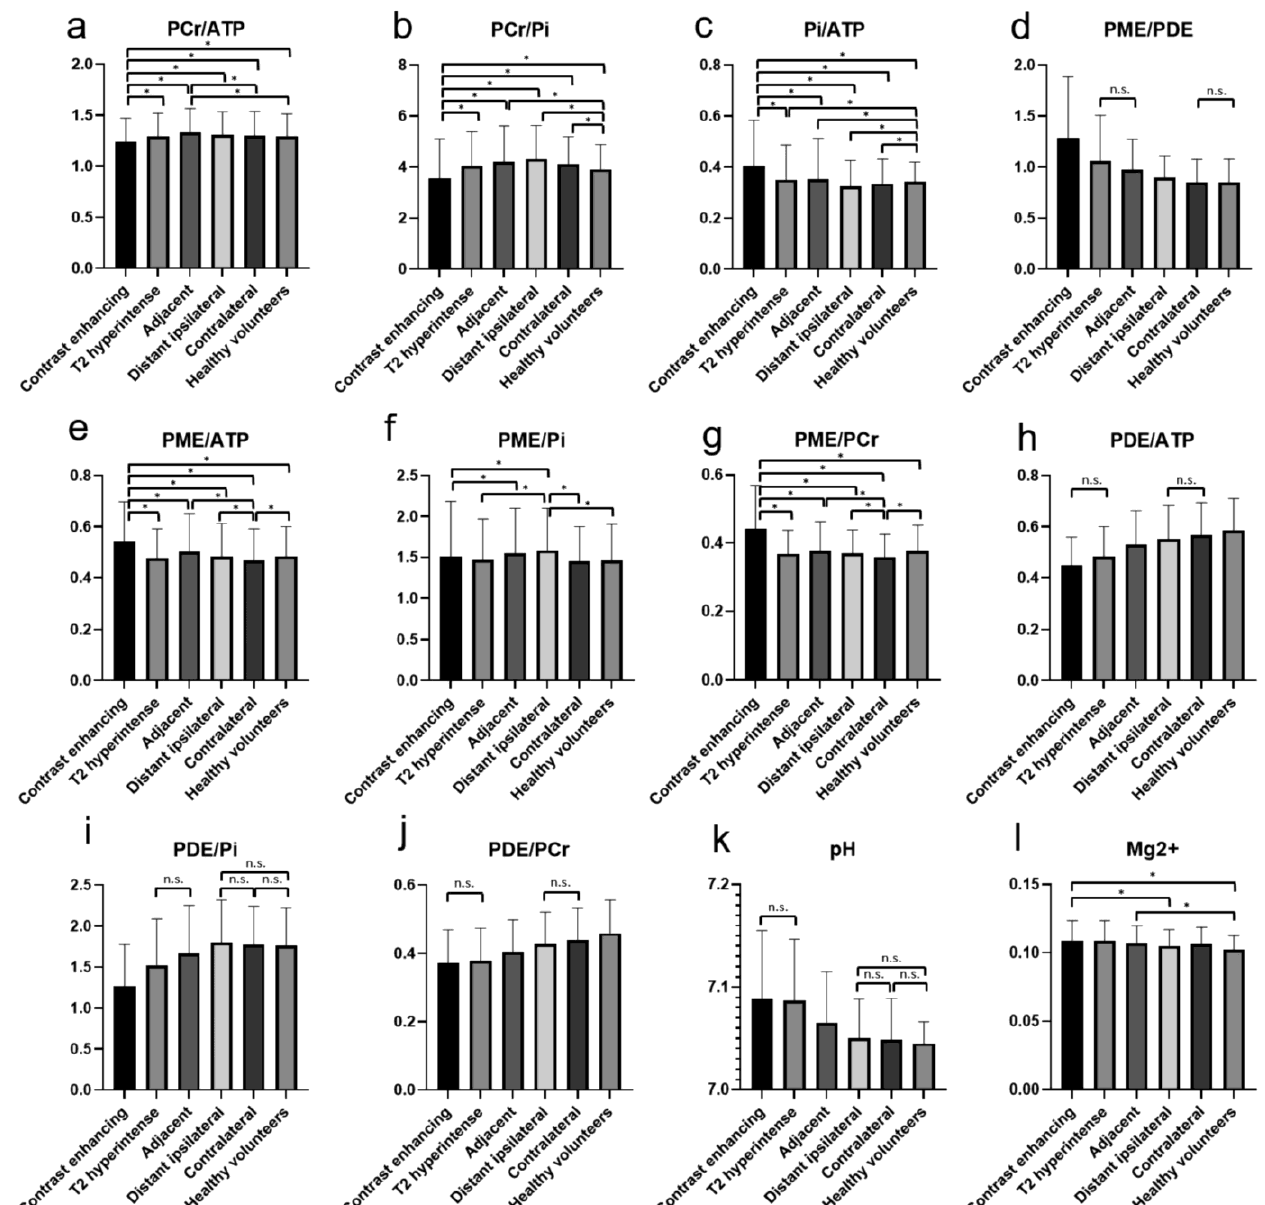
Figure 3. The different metabolite ratios of PCr/ATP ( a ), PCr/Pi ( b ), Pi/ATP ( c ), PME/PDE ( d ), PME/ATP ( e ), PME/Pi ( f ), PME/PCr ( g ), PDE/ATP ( h ), PDE/Pi ( i ), PDE/PCr ( j ), as well as pH ( k ) and Mg 2+ ( l ), with mean values and standard deviations for the different investigated areas. Significant differences are marked with “*”. For some ratios, in which most differences are significant, the not-significant relationships are marked with a horizontal line and “n.s.”. The values of the y -axis ( a – j ) are ratios and, therefore, displayed without units.